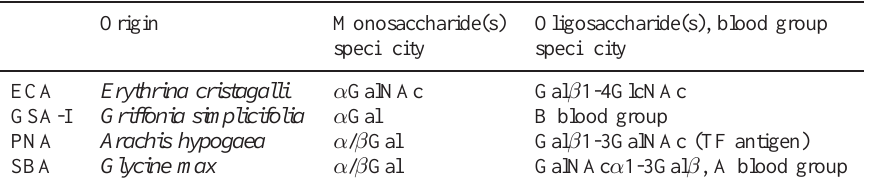
Table 1 Biological origin and binding specificity of lectins applied in this